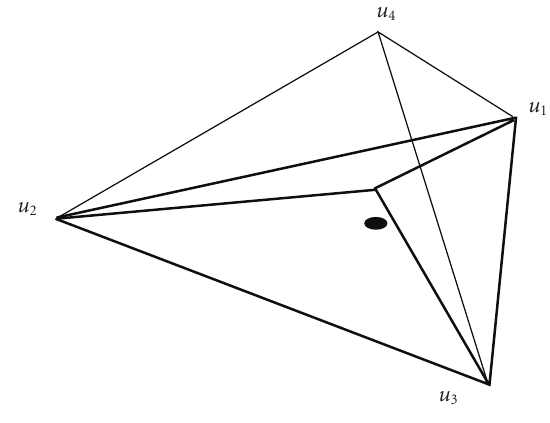
Figure 3.2. A horoball centered at ( u 1 + u 2 + u 3 ) /